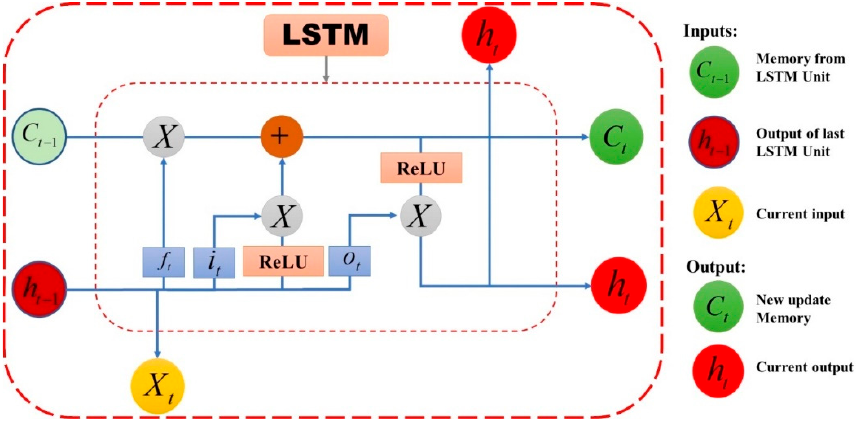
Figure 5. The architecture of LSTM memory blocks has one cell and three gate